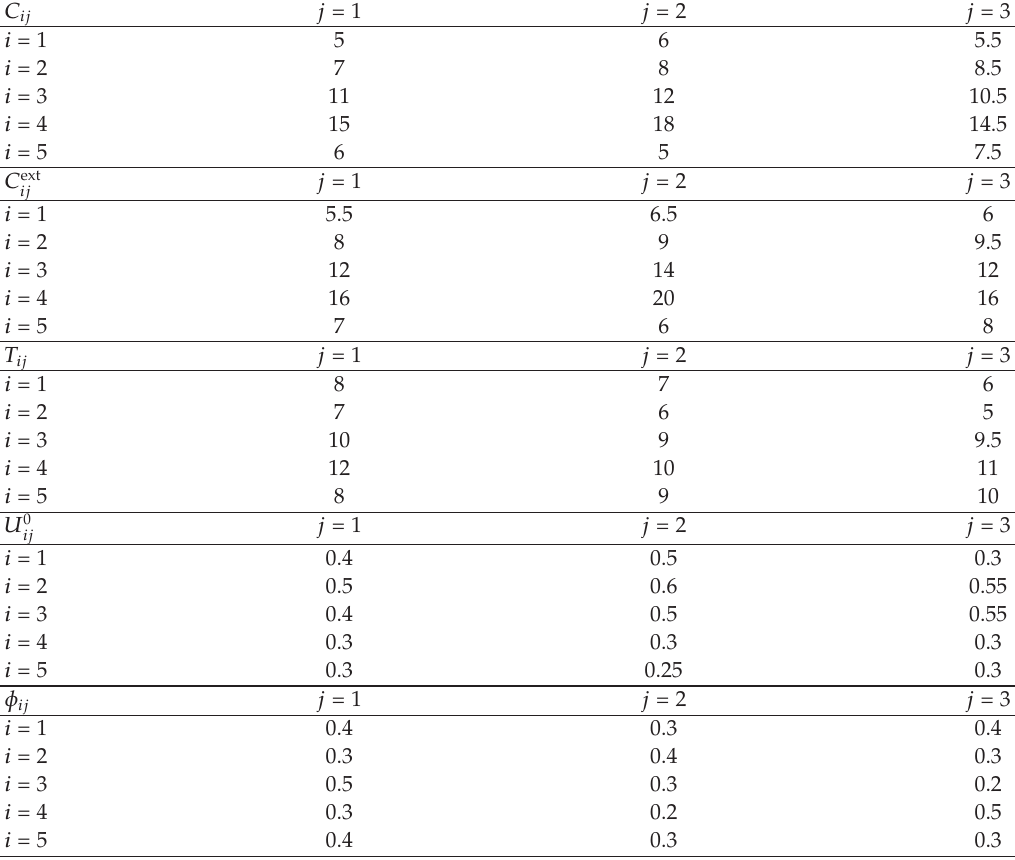
Table 2: Basic data (cid:2) 3.1 (cid:3) .